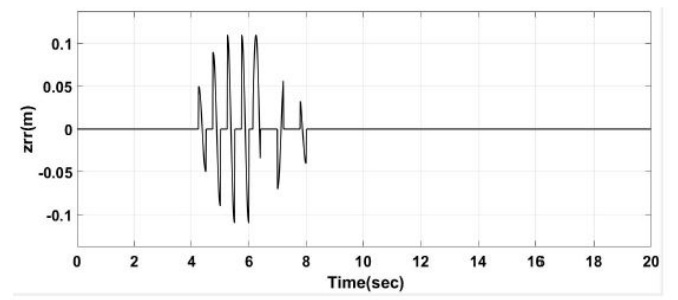
Figure 6. Front Road Disturbance PN.